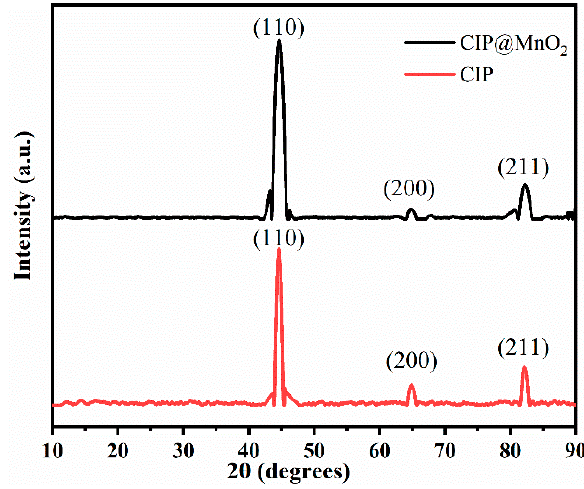
Figure 2. XRD spectra of CIP and CIP@MnO 2 composites.